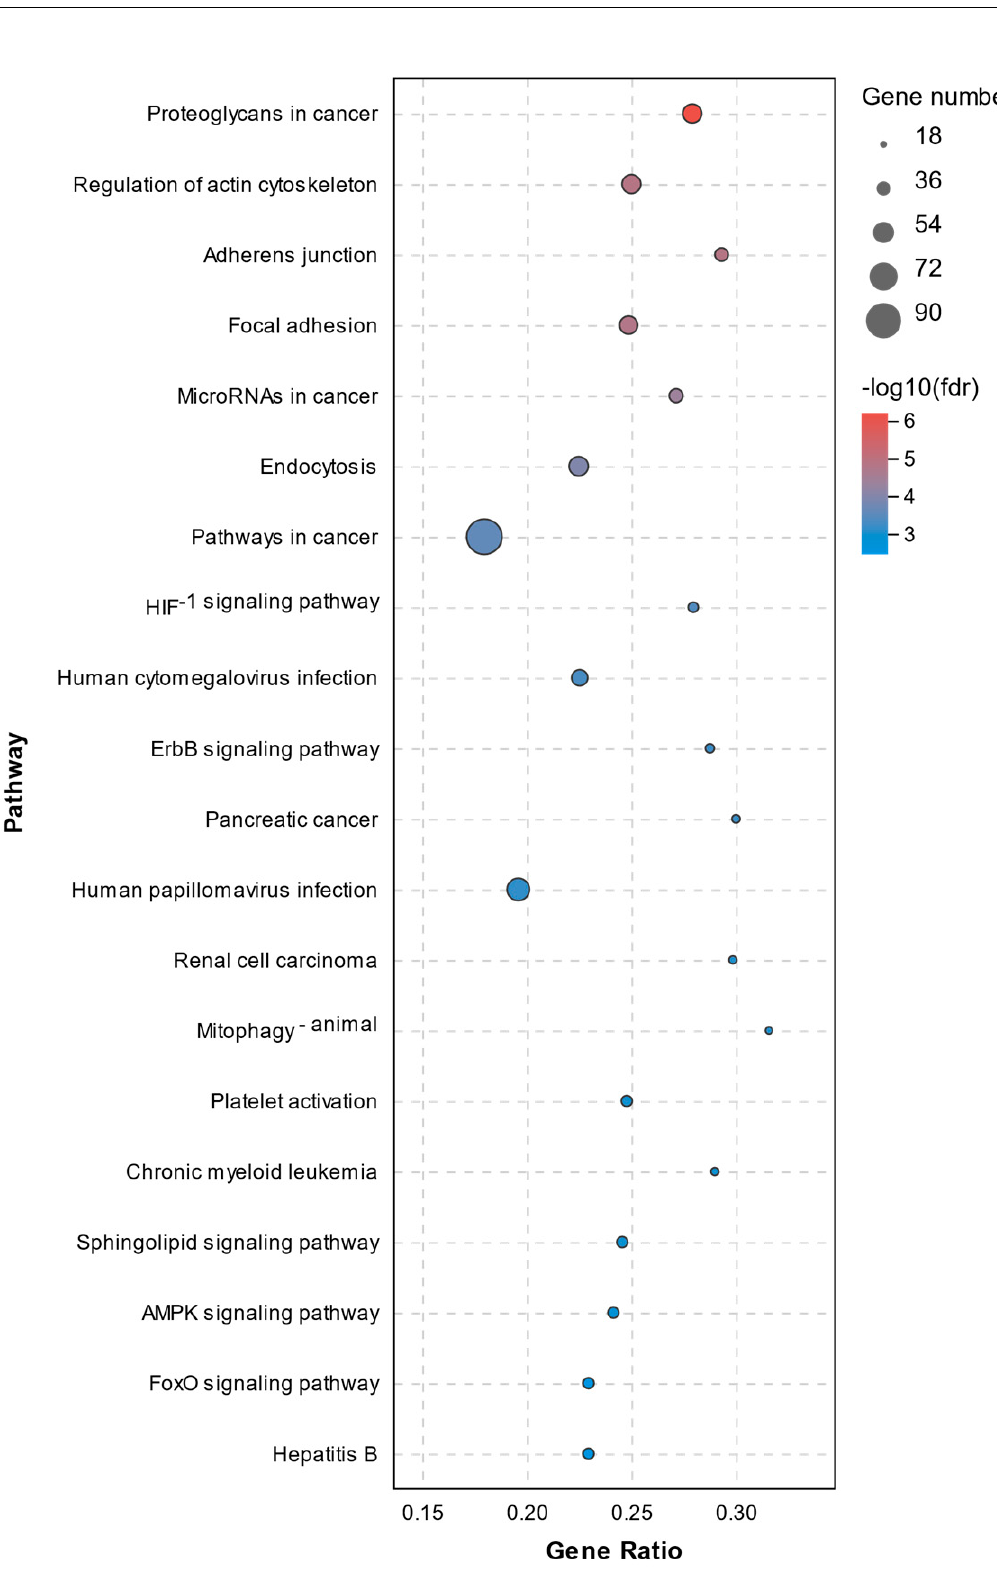
Figure 8. Top 20 KEGG pathway analysis of DEGs between the C1 and T1 groups.